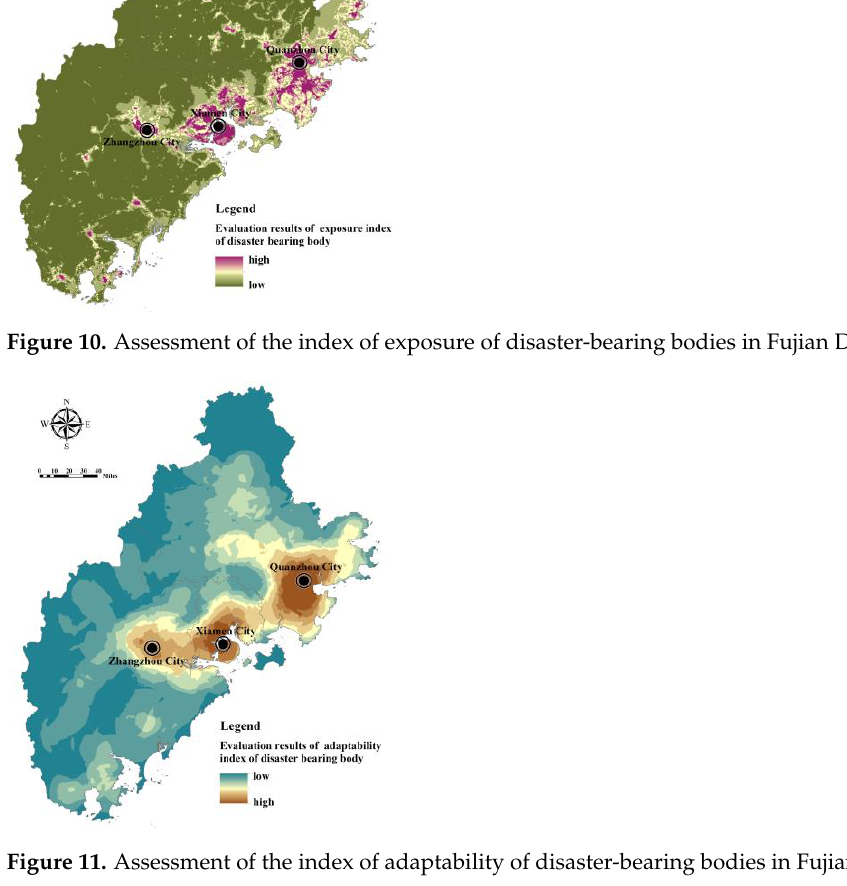
Figure 11. Assessment of the index of adaptability of disaster-bearing bodies in Fujian Delta.